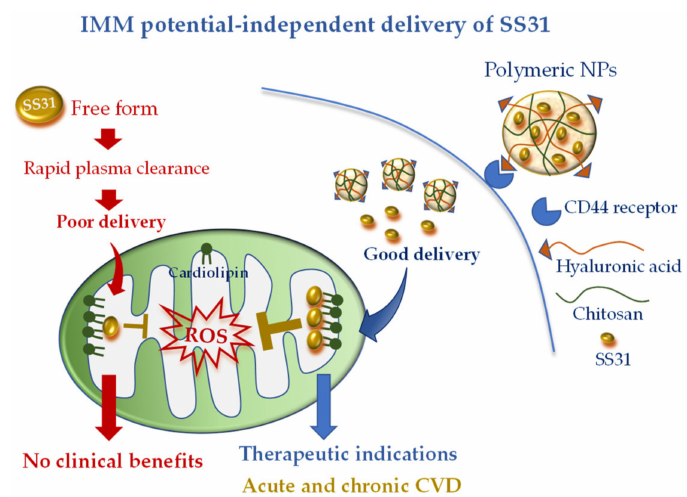
Figure 2. Mitochondria-targeted delivery of SS31 in free form versus nanoparticle (NP) formulation. Free SS31 is more prone to plasmatic degradation and rapid clearance, which might have undermined clinical benefit. NP formulation, with cell targeting moiety (hyaluronic acid) and higher mitochondrial uptake, is expected to confer promising therapeutic e ffi cacy either in acute or chronic cardiovascular disease